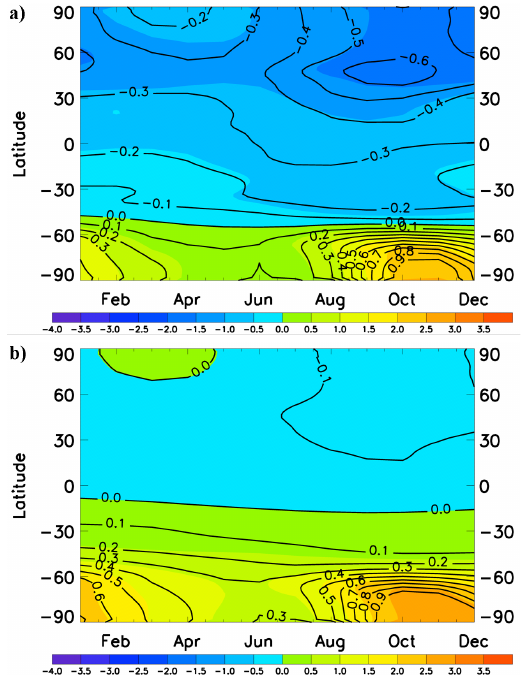
Figure 7. Zonal mean stratospheric column O 3 changes in units of DU (shown by color) and 2 Fig. 7. Zonal mean stratospheric column O 3 changes in units of DU the relative change in % (shown by contours) in the H 2 -ICE scenarios compared with the BL 3 (shown by color) and the relative change in % (shown by contours) scenarios as a function of latitude and time of a year for (a) A1FI and (b) B1 scenarios. 4 in the H 2 -ICE scenarios compared with the BL scenarios as a func- tion of latitude and time of a year for (a) A1FI and (b) B1 scenarios.